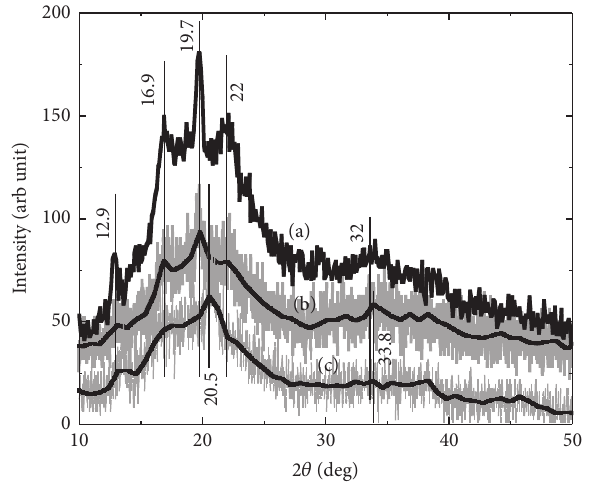
Figure 4: XRD pattern of sample P1 as obtained (a), after 2 hours of heating at 80 ∘ C (b), and after 2 hours of heating at 140 ∘ C (c). The shadow lines represent the experimental data as recorded and the solid lines represent the data after smoothing.